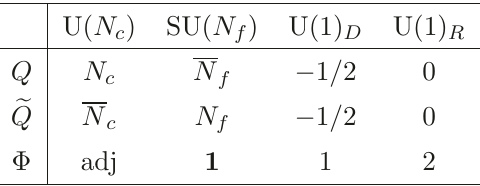
Table 3 . The charge assignment of